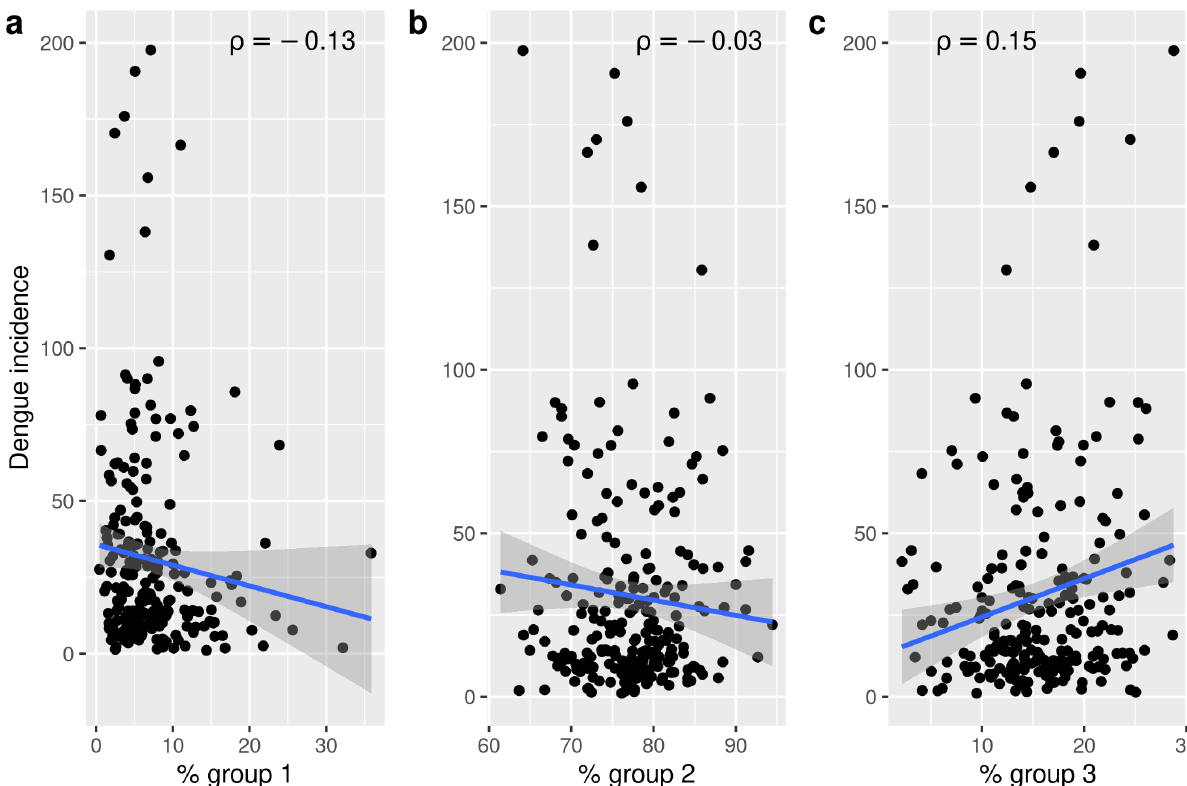
Figure 9. Dengue incidence (number of cases per 10,000 inhabitants) as a function of the percentage of pixels of different temporal patterns per neighbourhood. ( a ) Percentage of the neighbourhood covered by temporal pattern 1; ( b ) Percentage of the neighbourhood covered by temporal pattern 2 and; ( c ) Percentage of the neighbourhood covered by temporal pattern